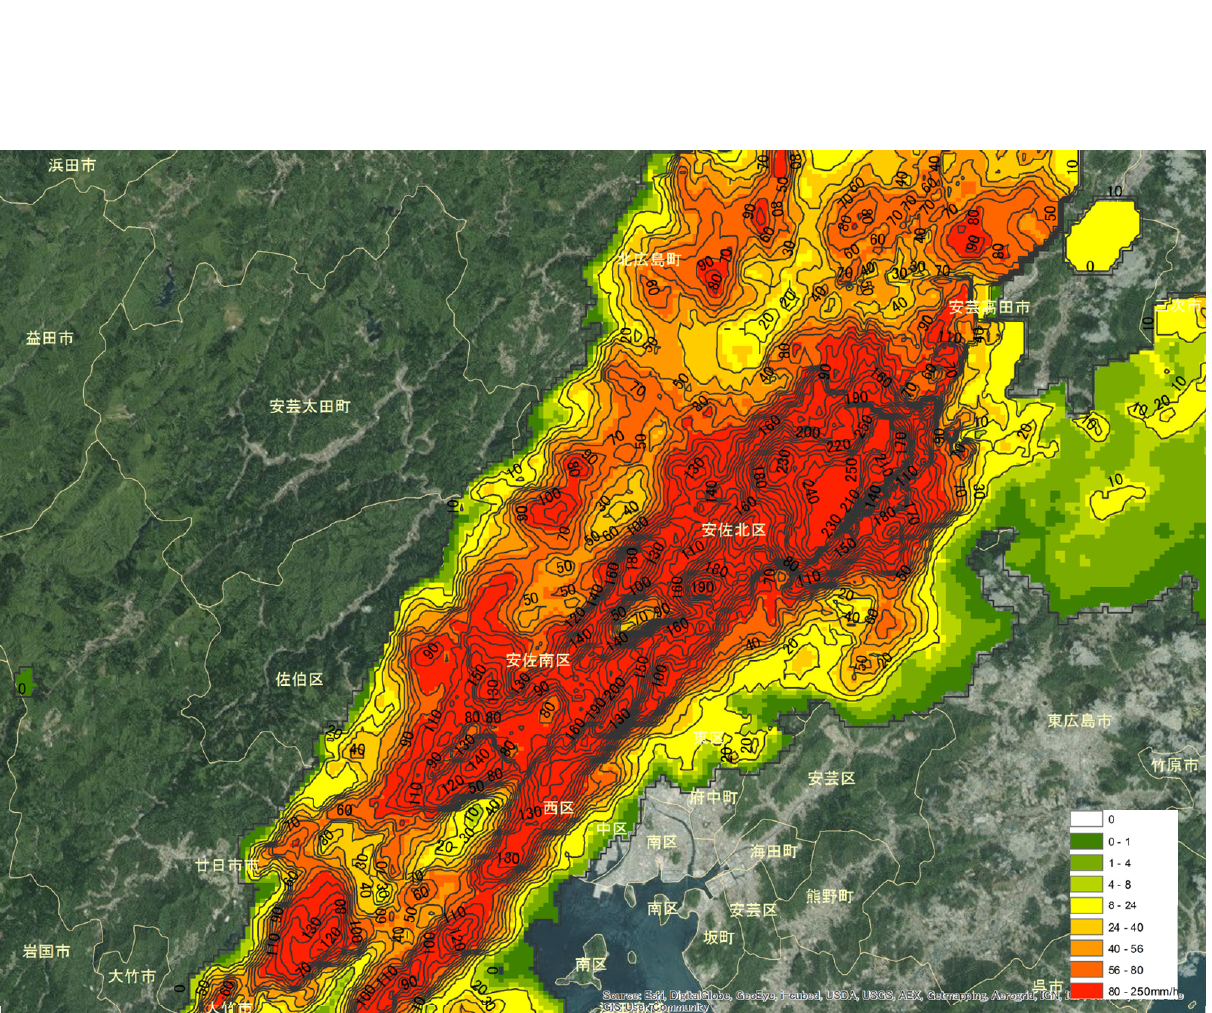
Figure 19. Amount of accumulated rainfall measured by the X-band MP radar (2014 1:00–4:00, August